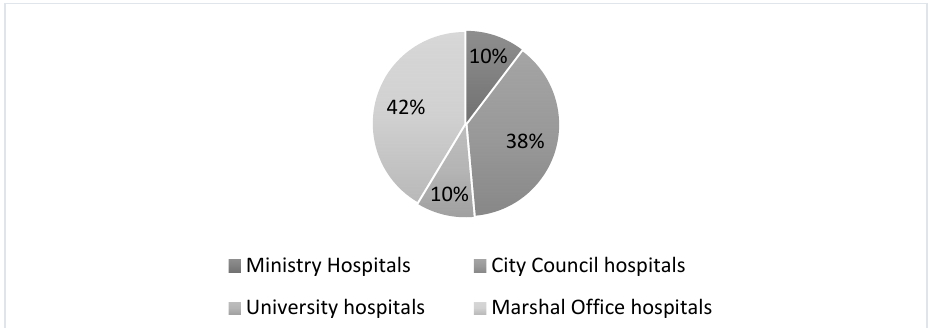
Figure 2. The structure of the analyzed hospitals according to the founding body.